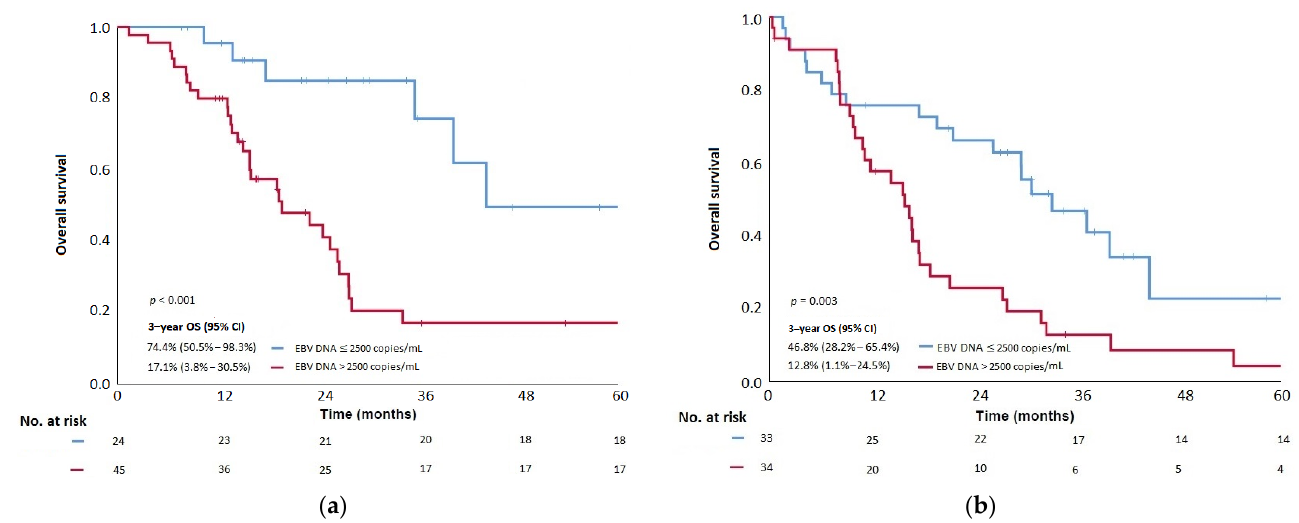
Figure 4. Kaplan–Meier curves showing ( a ) overall survival (OS) of patients of proposed M1a and M1b categories stratified by the pre-treatment plasma EBV DNA >2500 copies/mL in prognostic- RPA groups derived in Set 2 RPA in the training cohort, ( b ) OS of patients of proposed M1a and M1b categories stratified by the pre-treatment plasma EBV DNA >2500 copies/mL in prognostic- RPA groups derived in Set 2 RPA in the validation cohort. RPA, recursive partitioning analysis; EBV DNA, Epstein–Barr virus deoxyribonucleic acid.